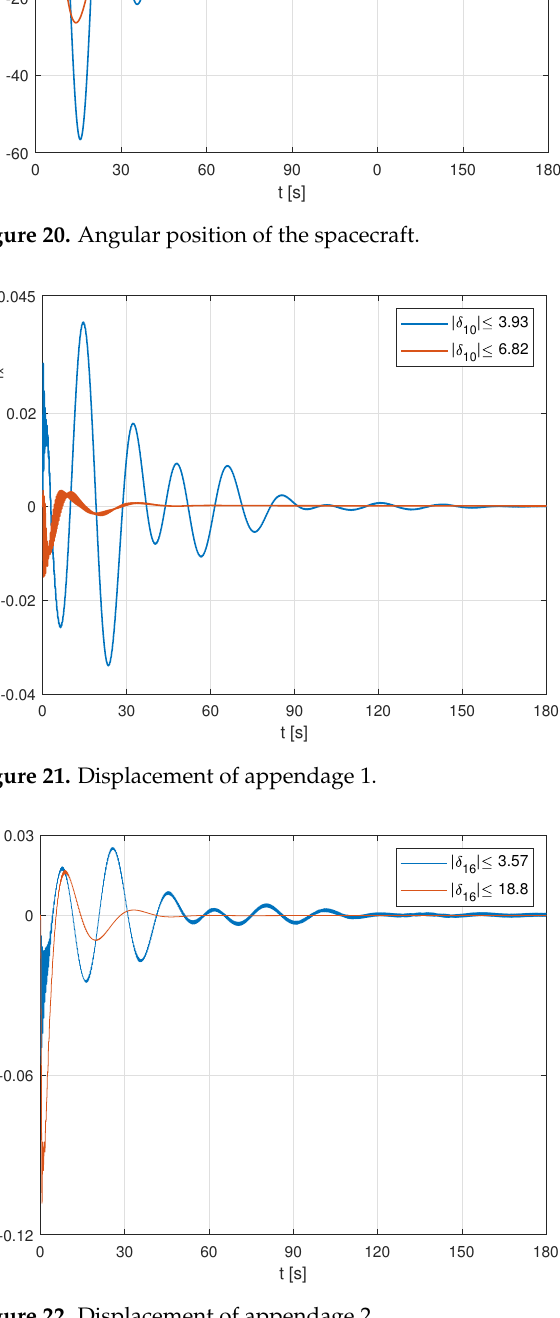
Figure 22. Displacement of appendage